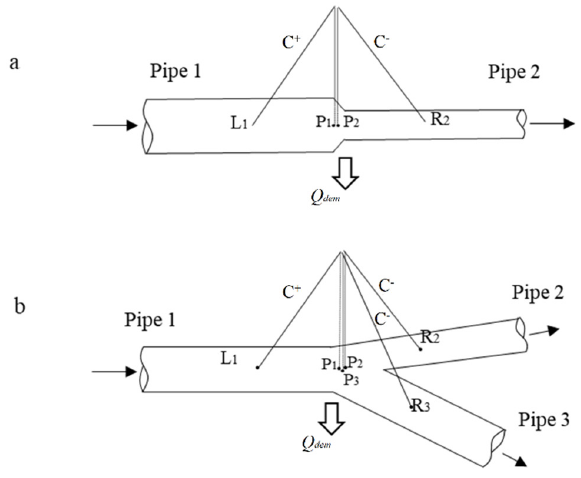
Figure 2. Boundary conditions at a typical series of (a) two and (b) three pipes junction.